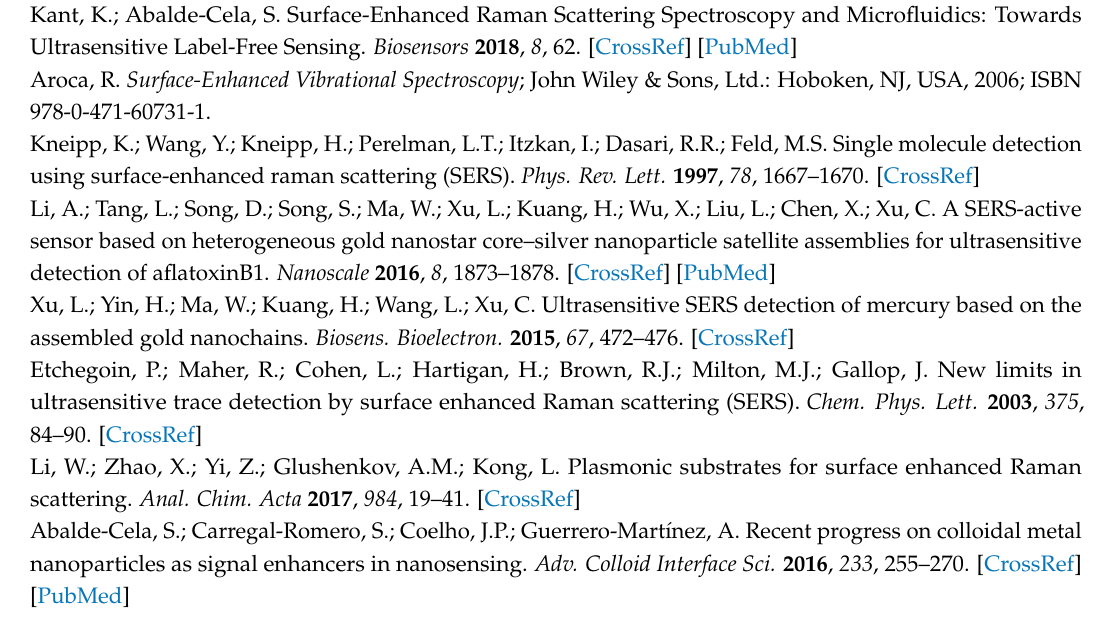
Figure S1: UV-vis extinction spectra of the AuNRs and Au@AgNRs and of GNSs, Figure S2: SEM images at different magnifications for three paper substrates with GNSs fabricated in the same conditions, Figure S3: Plotted average SERS intensity (log 10 ) and standard deviation for different concentrations of 1NAT for 5 measurements at different places of the GNSs substrate., Figure S4: Mapping (100 × 100 um; step size 4 um) obtained by plotting the SERS intensity of the characteristic band of the 1NAT at 1368 cm − 1 for GNSs and